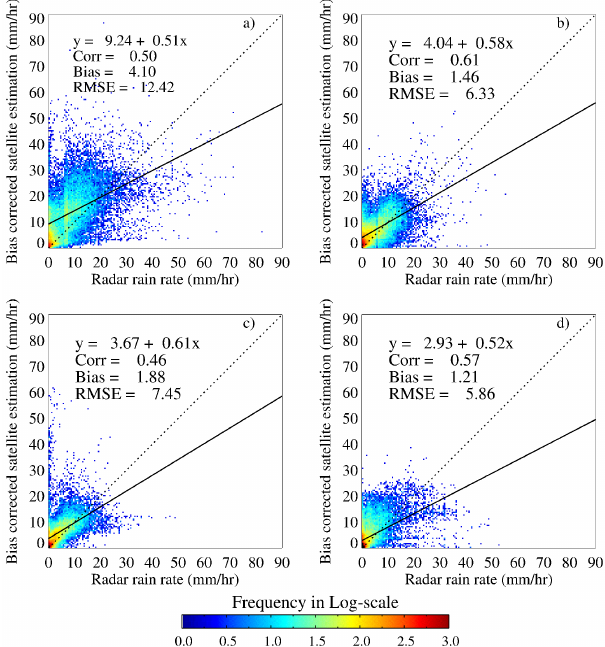
Figure 5. Scatter density diagrams of the radar rain rate estima- tion and satellite estimated precipitation after bias correction for the four precipitation cases of (a) case 1, (b) case 2, (c) case 3, and (d) case 4. Comparison statistics including correlation coefficient (Corr), bias, and root-mean-square error (RMSE) are also presented in each